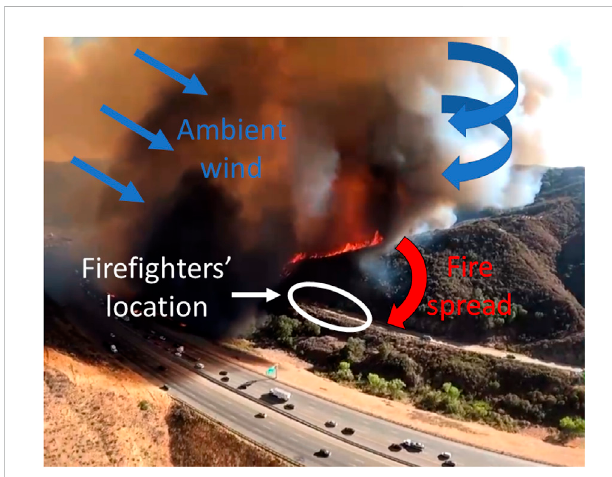
FIGURE 8 The ambient wind combined with a strong thermal plume on the Route Fire to create a large, slowly rotating vortex. The resulting near- surfacewind fl owcausedthe fi retospreadinahookingmotion,trapping fi re fi ghters. Video of the event can be seen at: https://www. youtube.com/watch?v=d4lus6ePx8U.